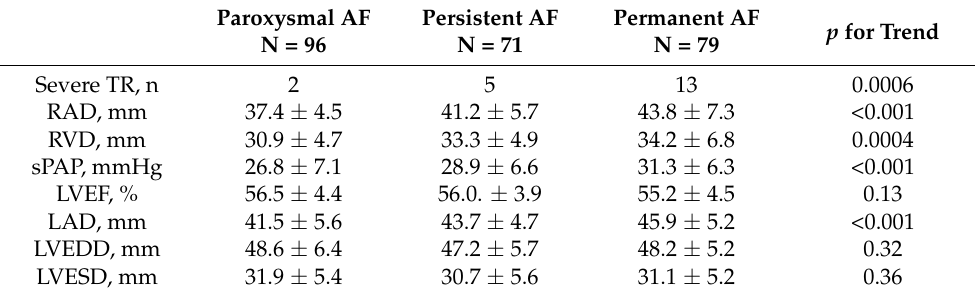
Table 2. Echocardiographic characteristics stratified by type of AF.